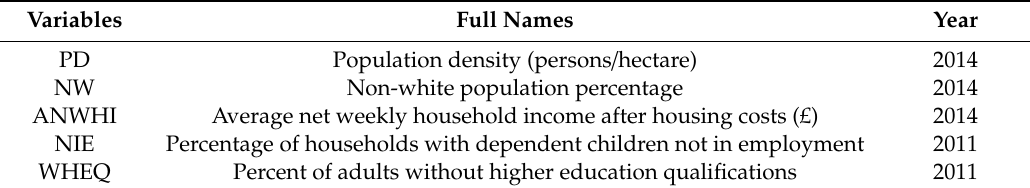
Table 1. Explanatory variables considered in the model.